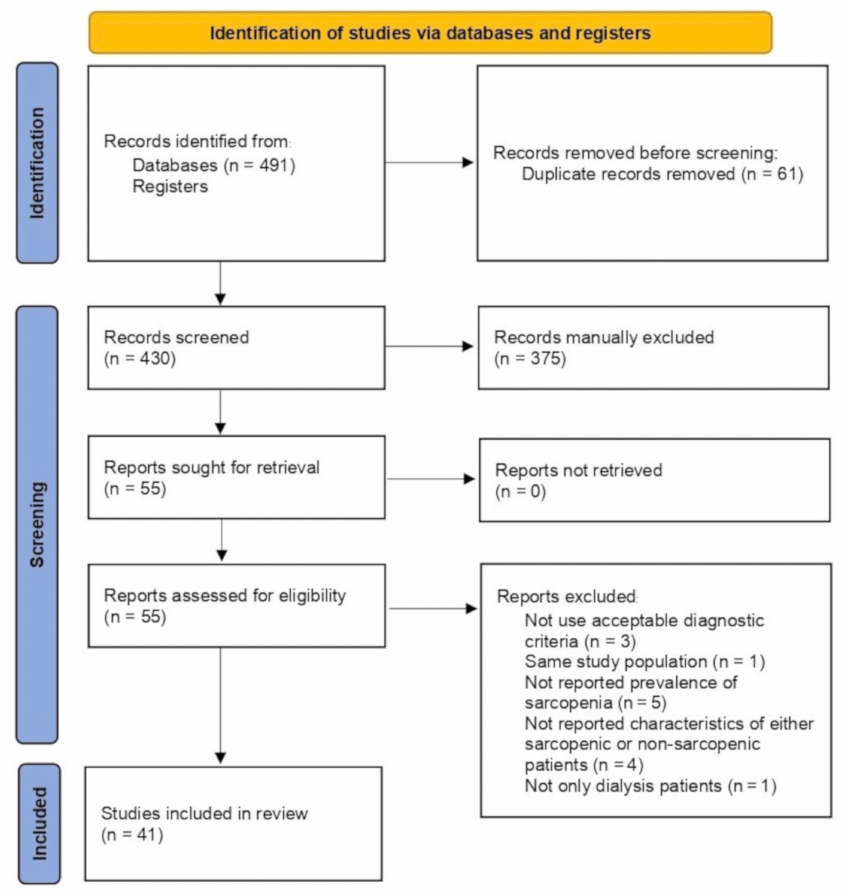
Figure 1. PRISMA 2020 flow